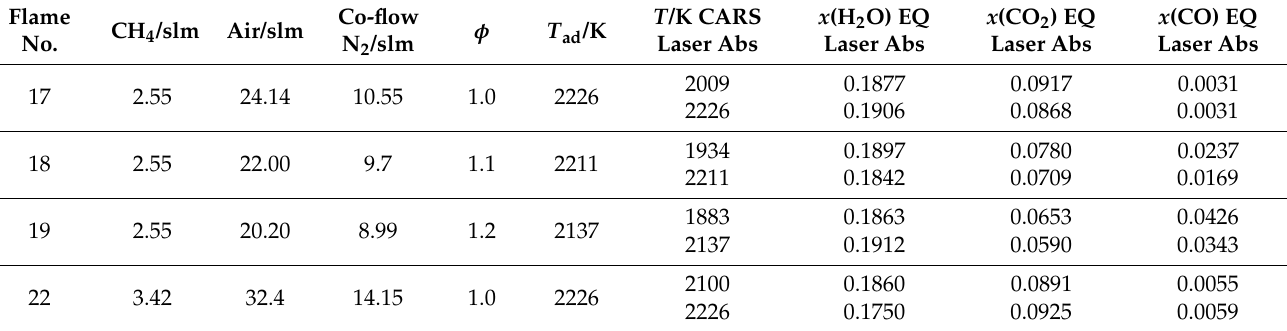
Table 2. Operating conditions of the four premixed CH 4 /air flames from Weigand et al. [34] examined in this work. Adiabatic flame temperatures and species mole fractions from equilibrium calculations (EQ) as well as measured CARS temperatures as listed from [34]. CARS temperatures were measured at 15 mm HAB. Measured laser absorption temperature and species mole fractions from this work are listed below the reference